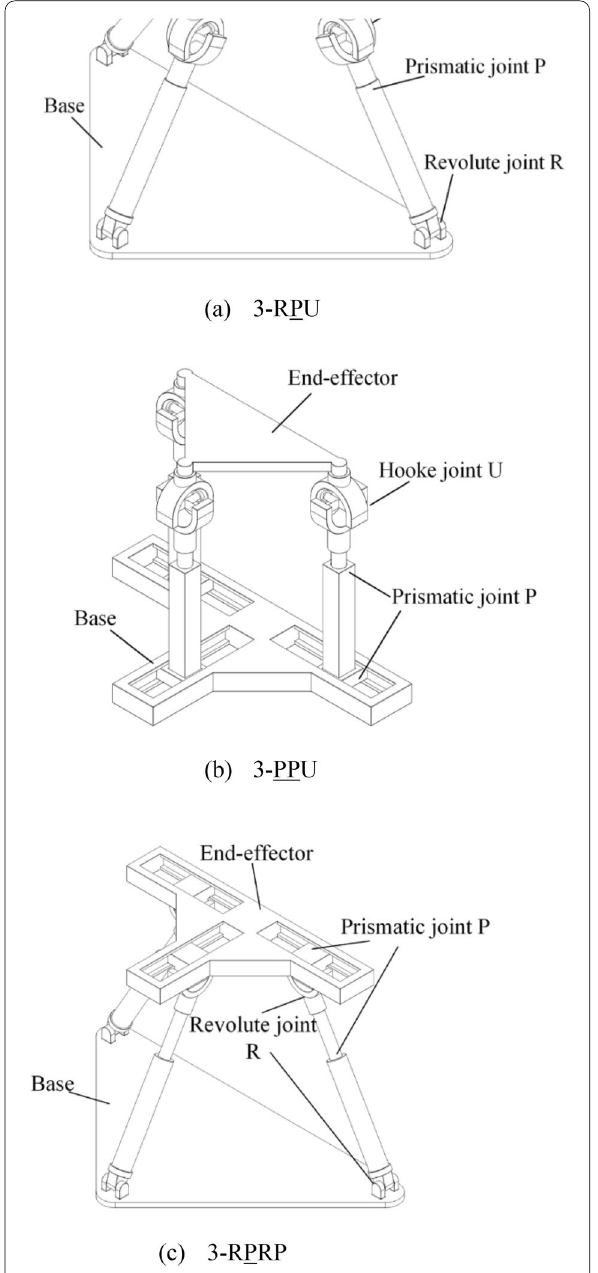
Figure 7 Constructed 2R1T PM with rotational bifurcation without parasitic motion